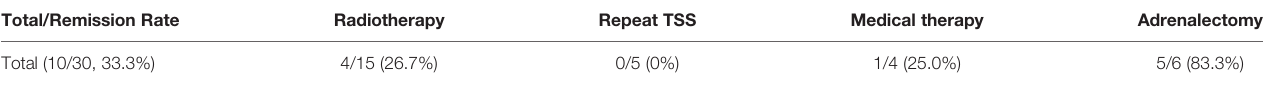
TABLE 6 | Further treatments and remission rate in persistent and recurrent patients with invasive corticotroph